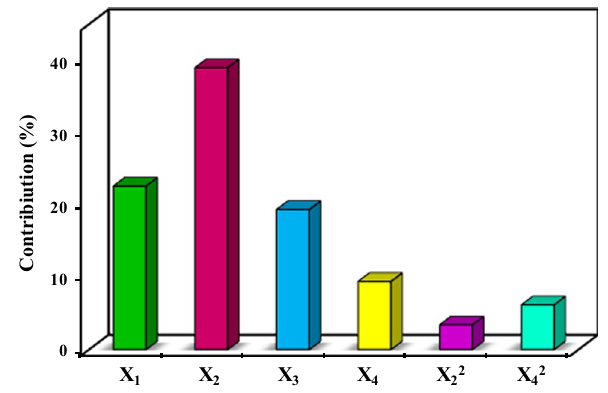
Fig. 1 Pareto analysis for developed HDZ removal model